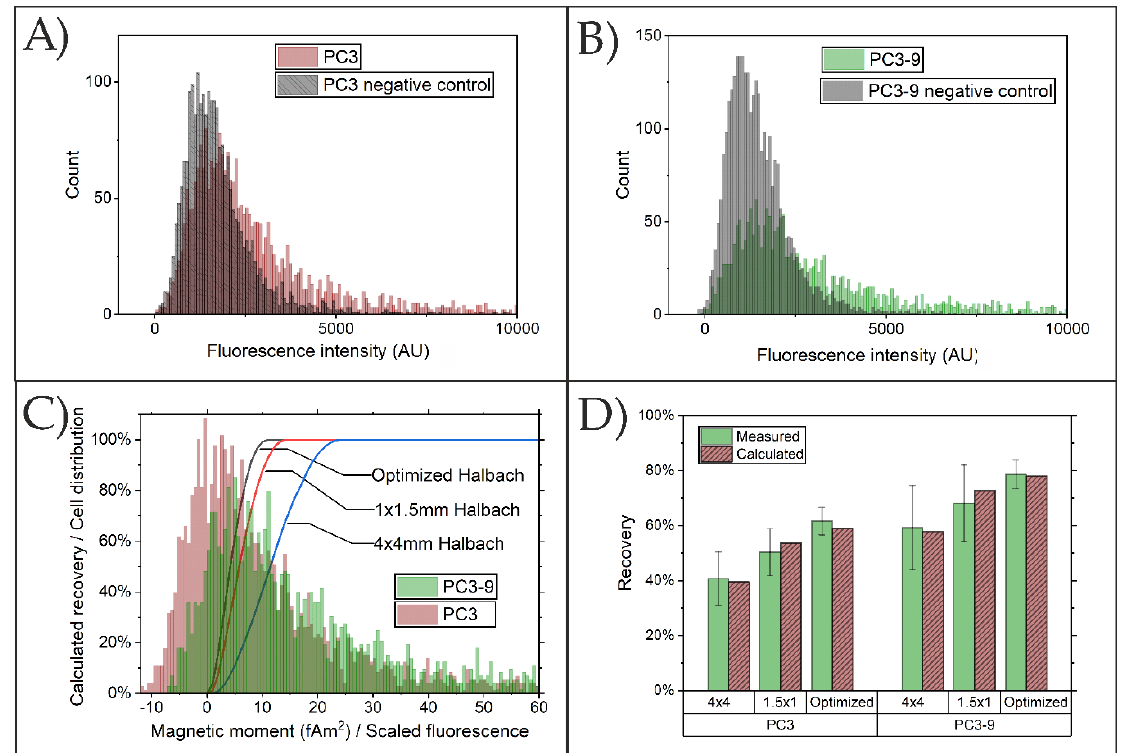
Figure 11. Fluorescence intensity of ferrofluid bound to ( A ) PC3; ( B ); PC3-9, showing clear overlap with negative control. ( C ) Combination of calculated recoveries and scaled ferrofluid distribution at best fit with experimental data. ( D ) Measured recoveries compared to recoveries calculated using the scaled